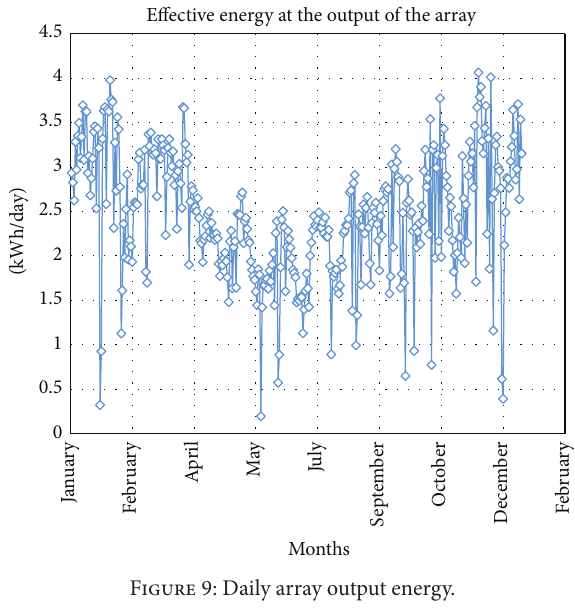
Figure 9: Daily array output energy.